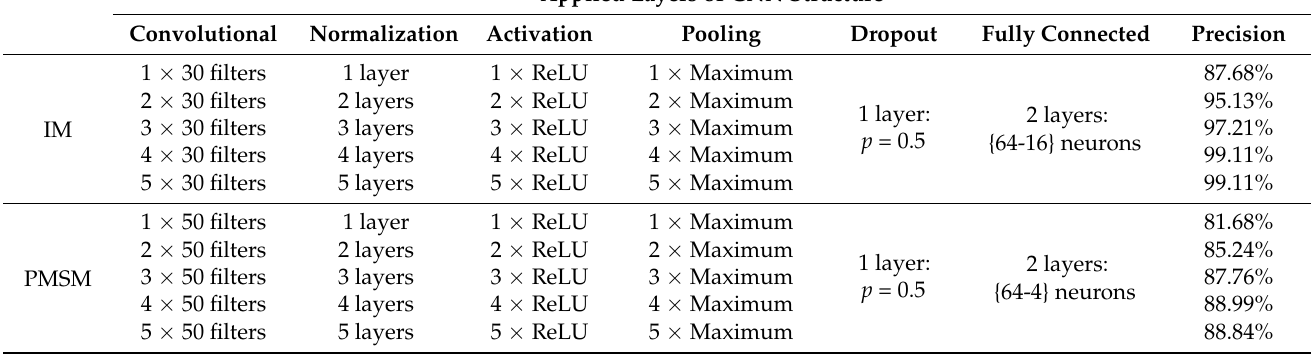
Table 1. Influence of the number of convolutional layers on the precision of a CNN-based diagnostic system: BNL for ε = 0.001. Applied Layers of CNN